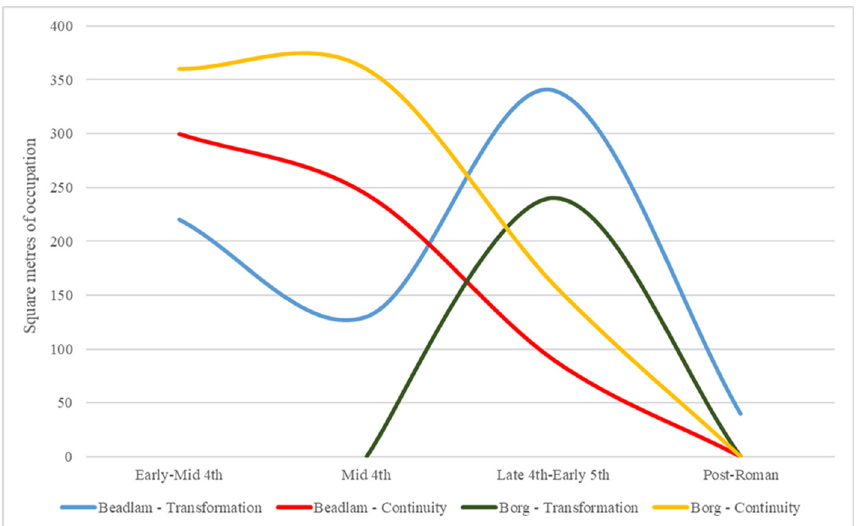
Figure 9: Practical applications of the data: different spatial trajectories of transformation and continuity at the two example sites measured in square metres (m²). The data from Borg has discounted evidence from unexcavated zones (J.